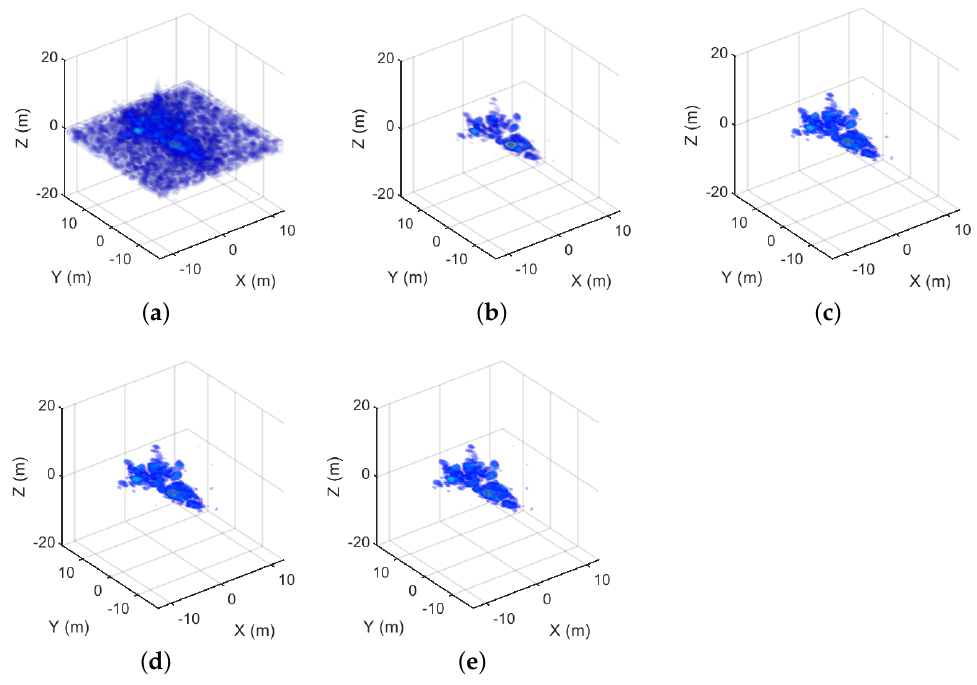
Figure 13. The imaging results of aircraft corresponding to the 25% sampling. ( a ) The MF result. ( b ) The FIST result. ( c ) The SCAD result. ( d ) The MCP result. ( e ) The GSALSA–Cauchy